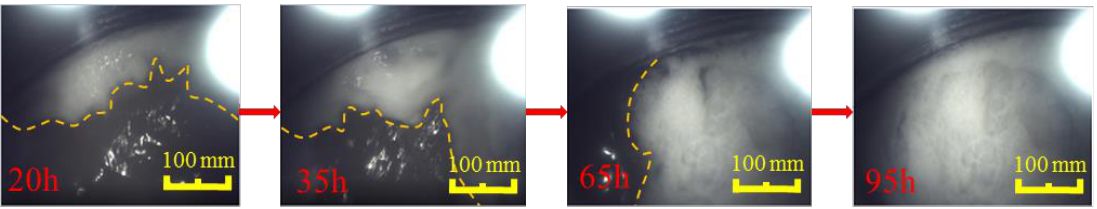
Figure 5. Temperature and pressure changes during preparation of hydrate in stirring method.